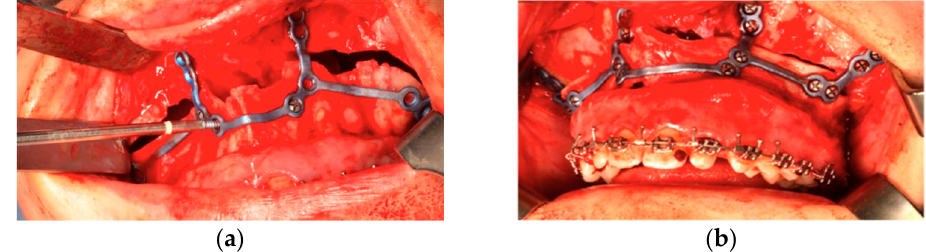
Figure 9. The plates positioned with osteosynthesis titanium screws. ( a ) during the positioning, ( b ) is in position.